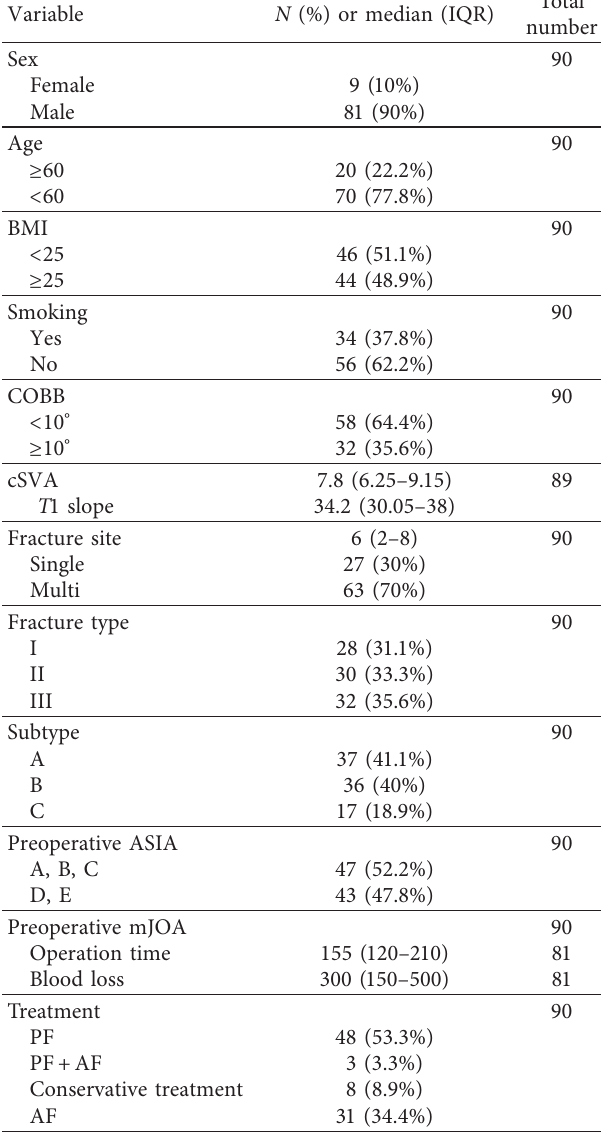
Table 1: Basic information.